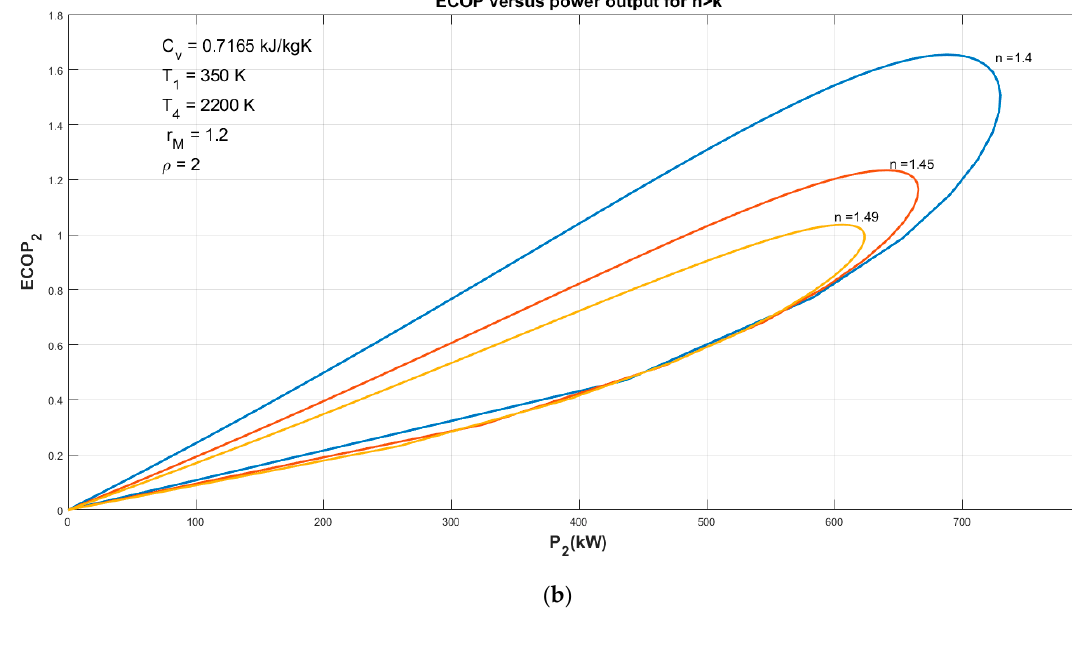
ff ect of n ( n > k ) on ECOP − ε ( a ), ECOP– P Figure 9. Effect of n ( n > k ) on ECOP −ε ( a ), ECOP– P 2 ( b ) and ECOP – 𝜂 2 ( c ). Figure 9. E